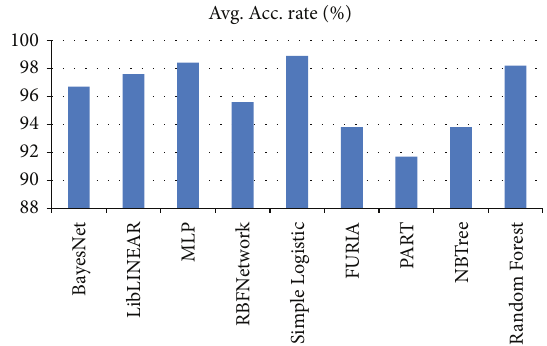
Figure 10: Comparison of average accuracy rate by different classifiers.